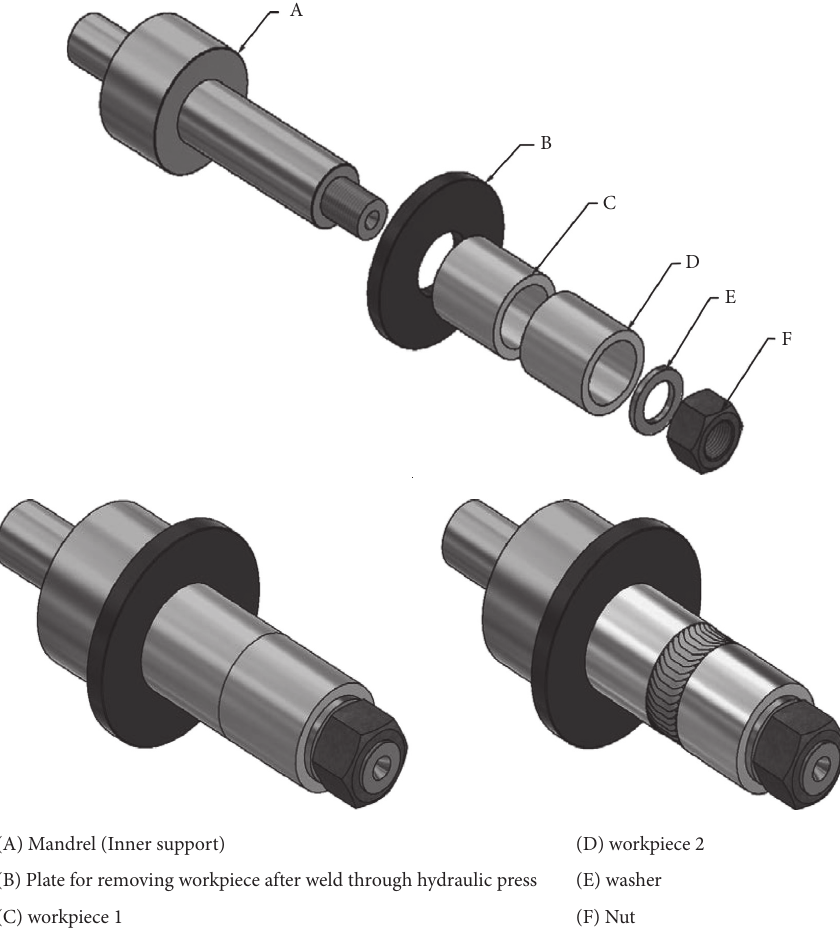
Figure 7: Developed fixture assembly for friction stir welding of AA 7075 aluminium alloys. Developed fixture assembly before and after the FSW process.